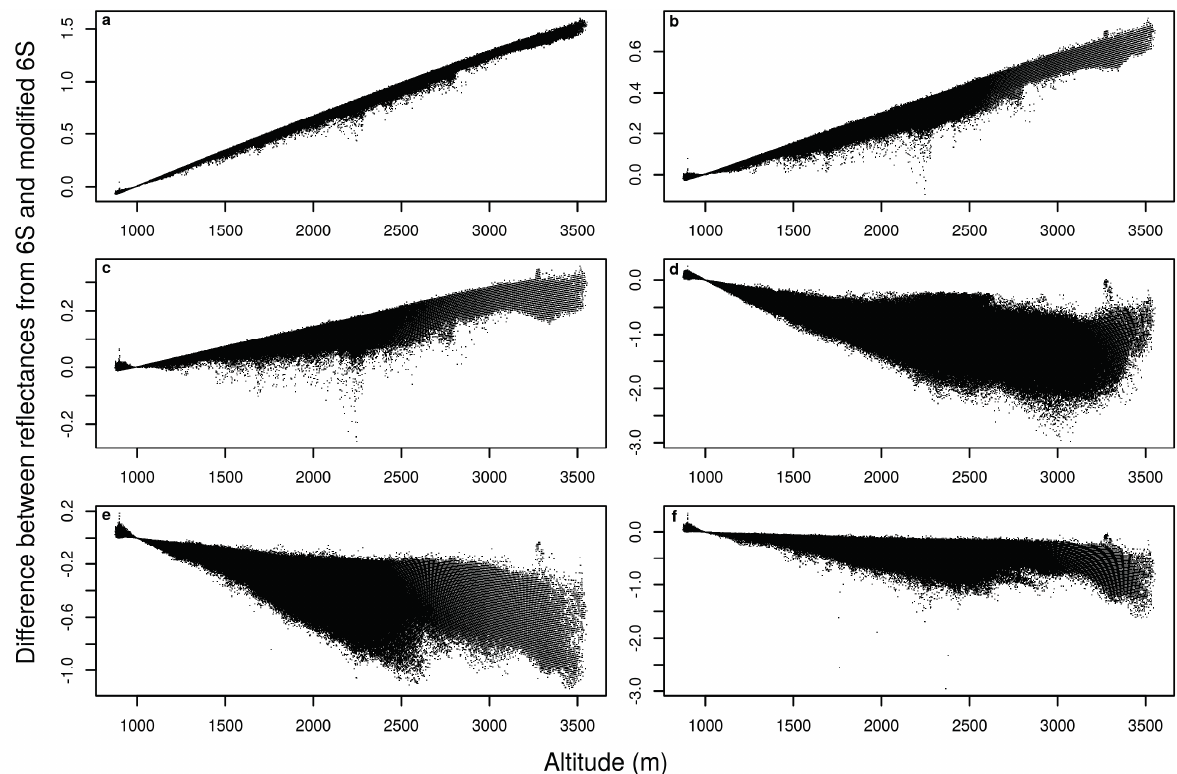
Figure 6. Difference between reflectance values in the ( a ) blue; ( b ) green; ( c ) red; ( d , e ) NIR 1 & 2; and ( f ) MIR bands of the Landsat ETM+ scene of 2001 after atmospheric correction with the original version of the 6S code (without the altitudinal factor) and with the modified 6S code (which includes the altitude). Note that the fixed altitude in the original 6S code was set to 1000